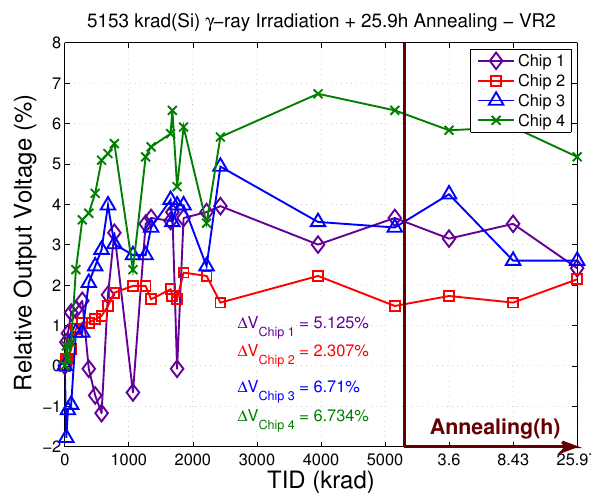
Figure 13. Relative output voltage (%) of the VR2 when exposed to γ -rays at a dose rate of 25 krad/h(Si).